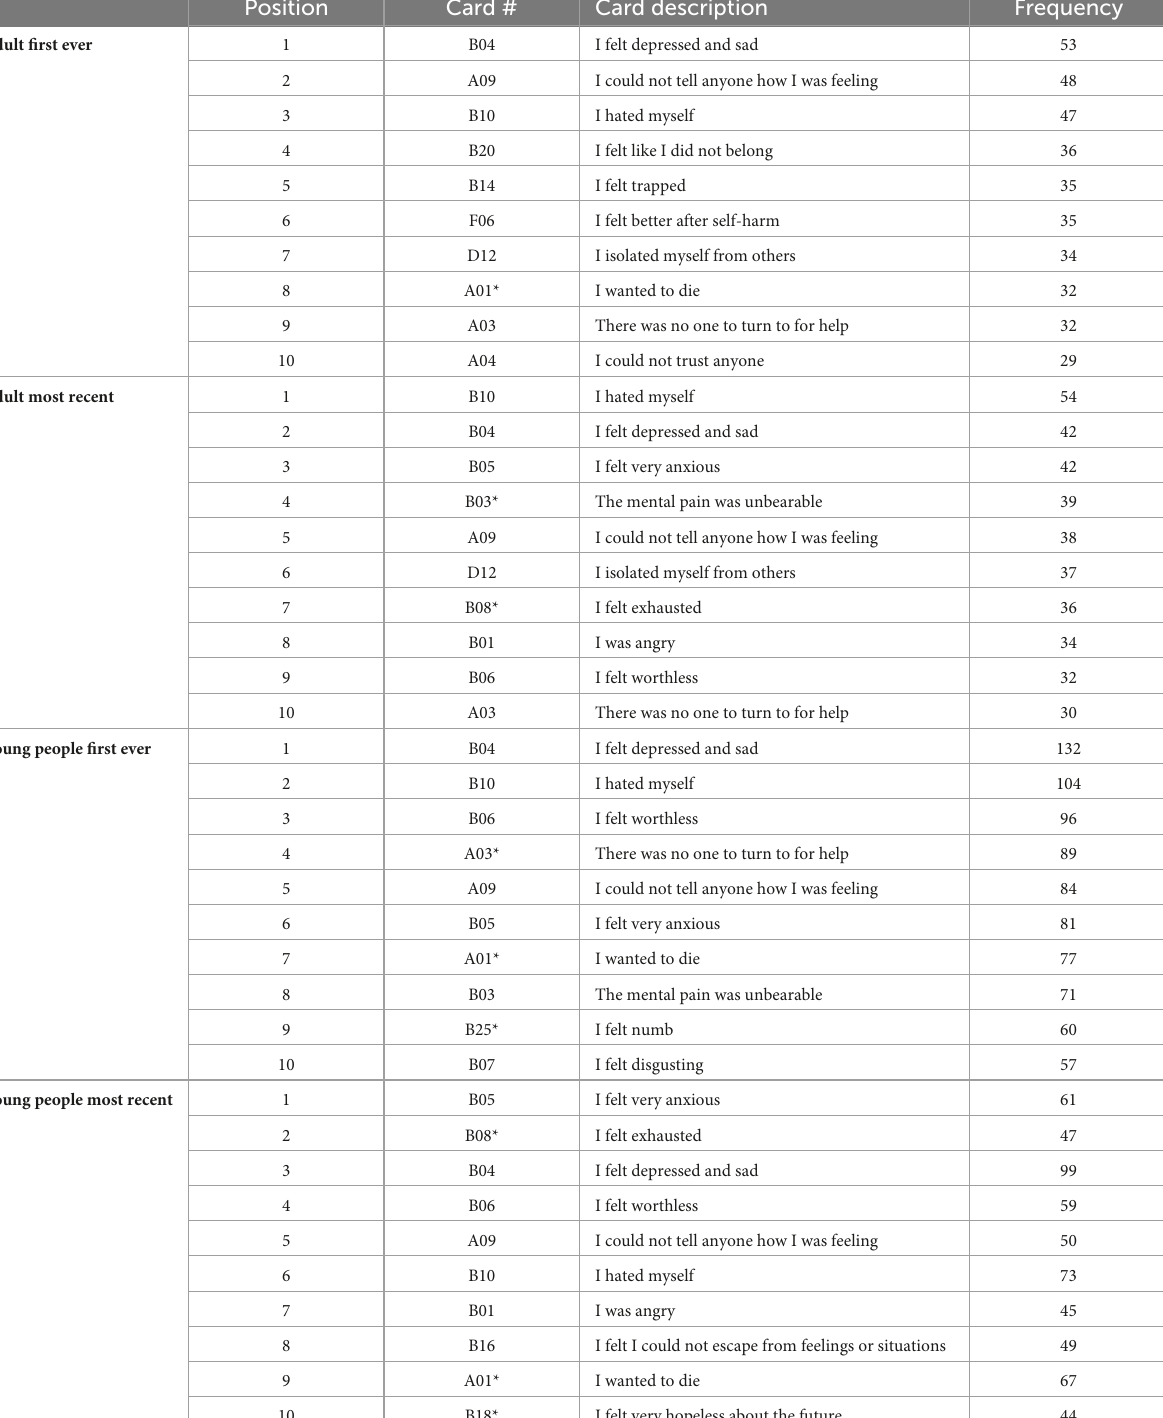
TABLE 1 A table displaying the most frequently selected cards, across the four